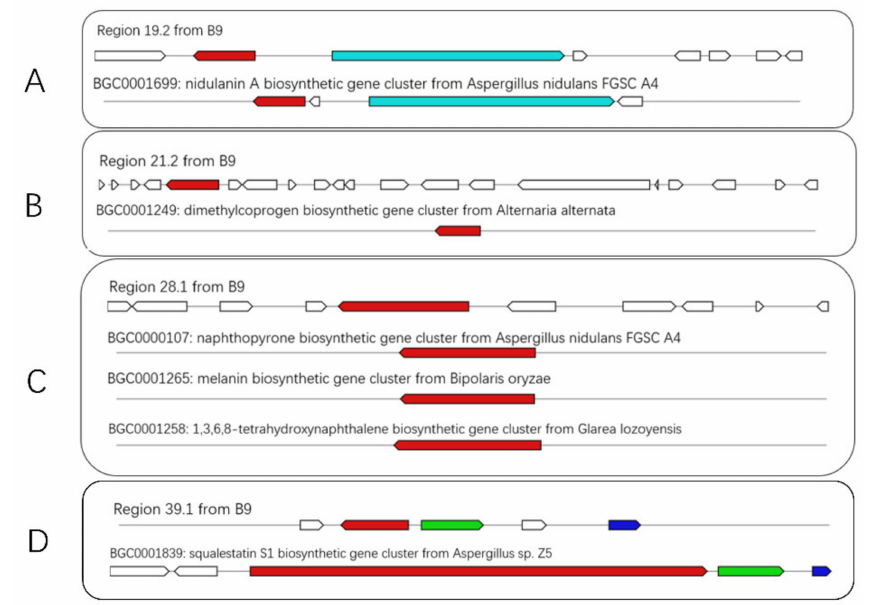
Figure 5. Schematic representation of B9 putative BGCs showing high homology with genes from characterized BGCs ( A – D ). The upper part represents the BGC in B9, and the lower part represents known BGCs in the MIBiG database. Homologous genes are shown in the same